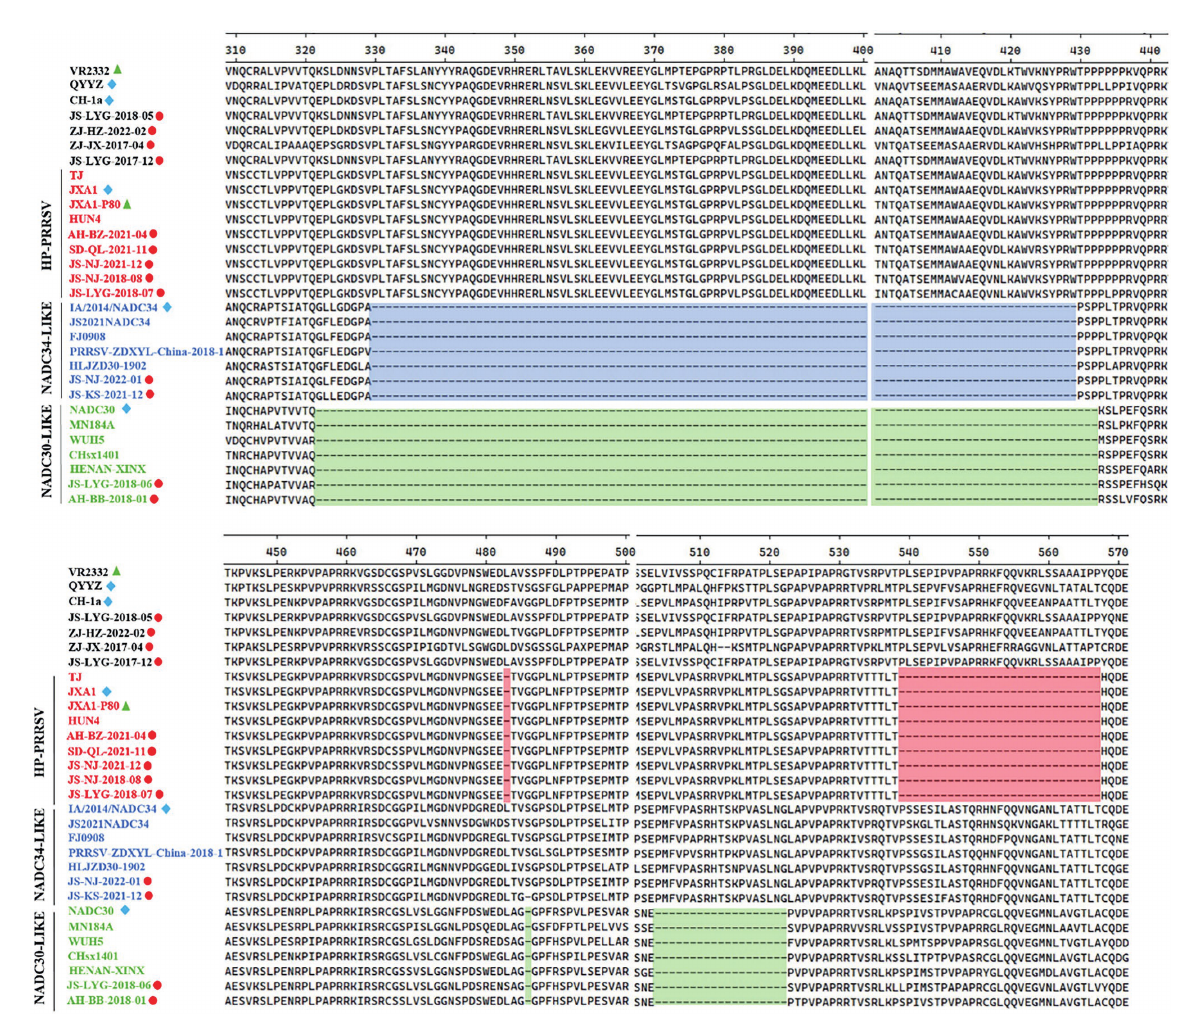
FIGURE 2 Alignment of the Nsp2 amino acid sequences of the 30 PRRSV strains. The 30-amino-acid discontinuous deletion of HP-PRRSVs is shown in red shadow. The 100-amino-acid continuous deletion of NADC34-like PRRSVs is shown in blue shadow. The 131-amino-acid discontinuous deletion of NADC30-like PRRSVs is shown in green shadow.